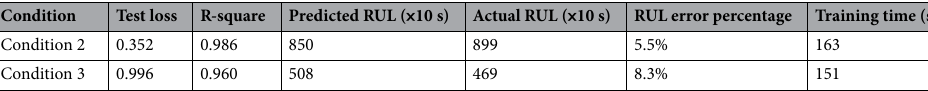
Table 10. Training performance of CNN with 2 cells under conditions 2 and